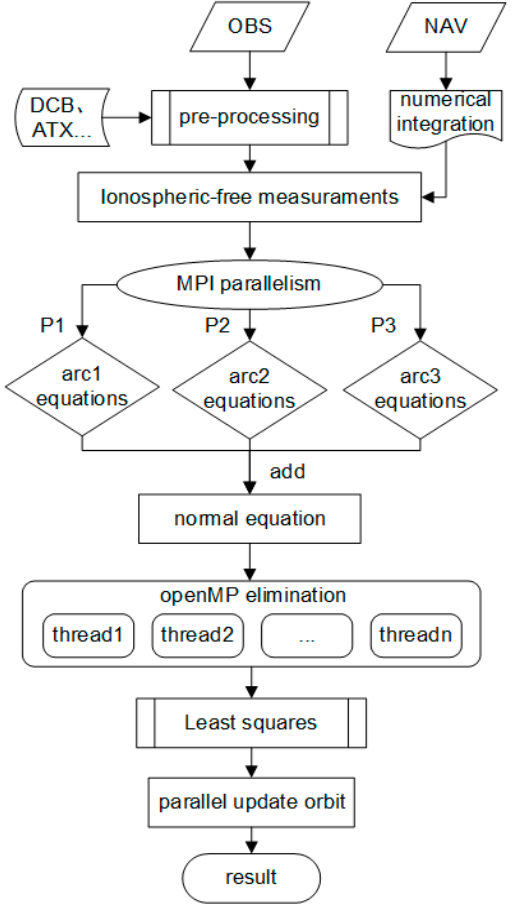
Figure 1. GNSS parallel precision orbit determination flowchart.